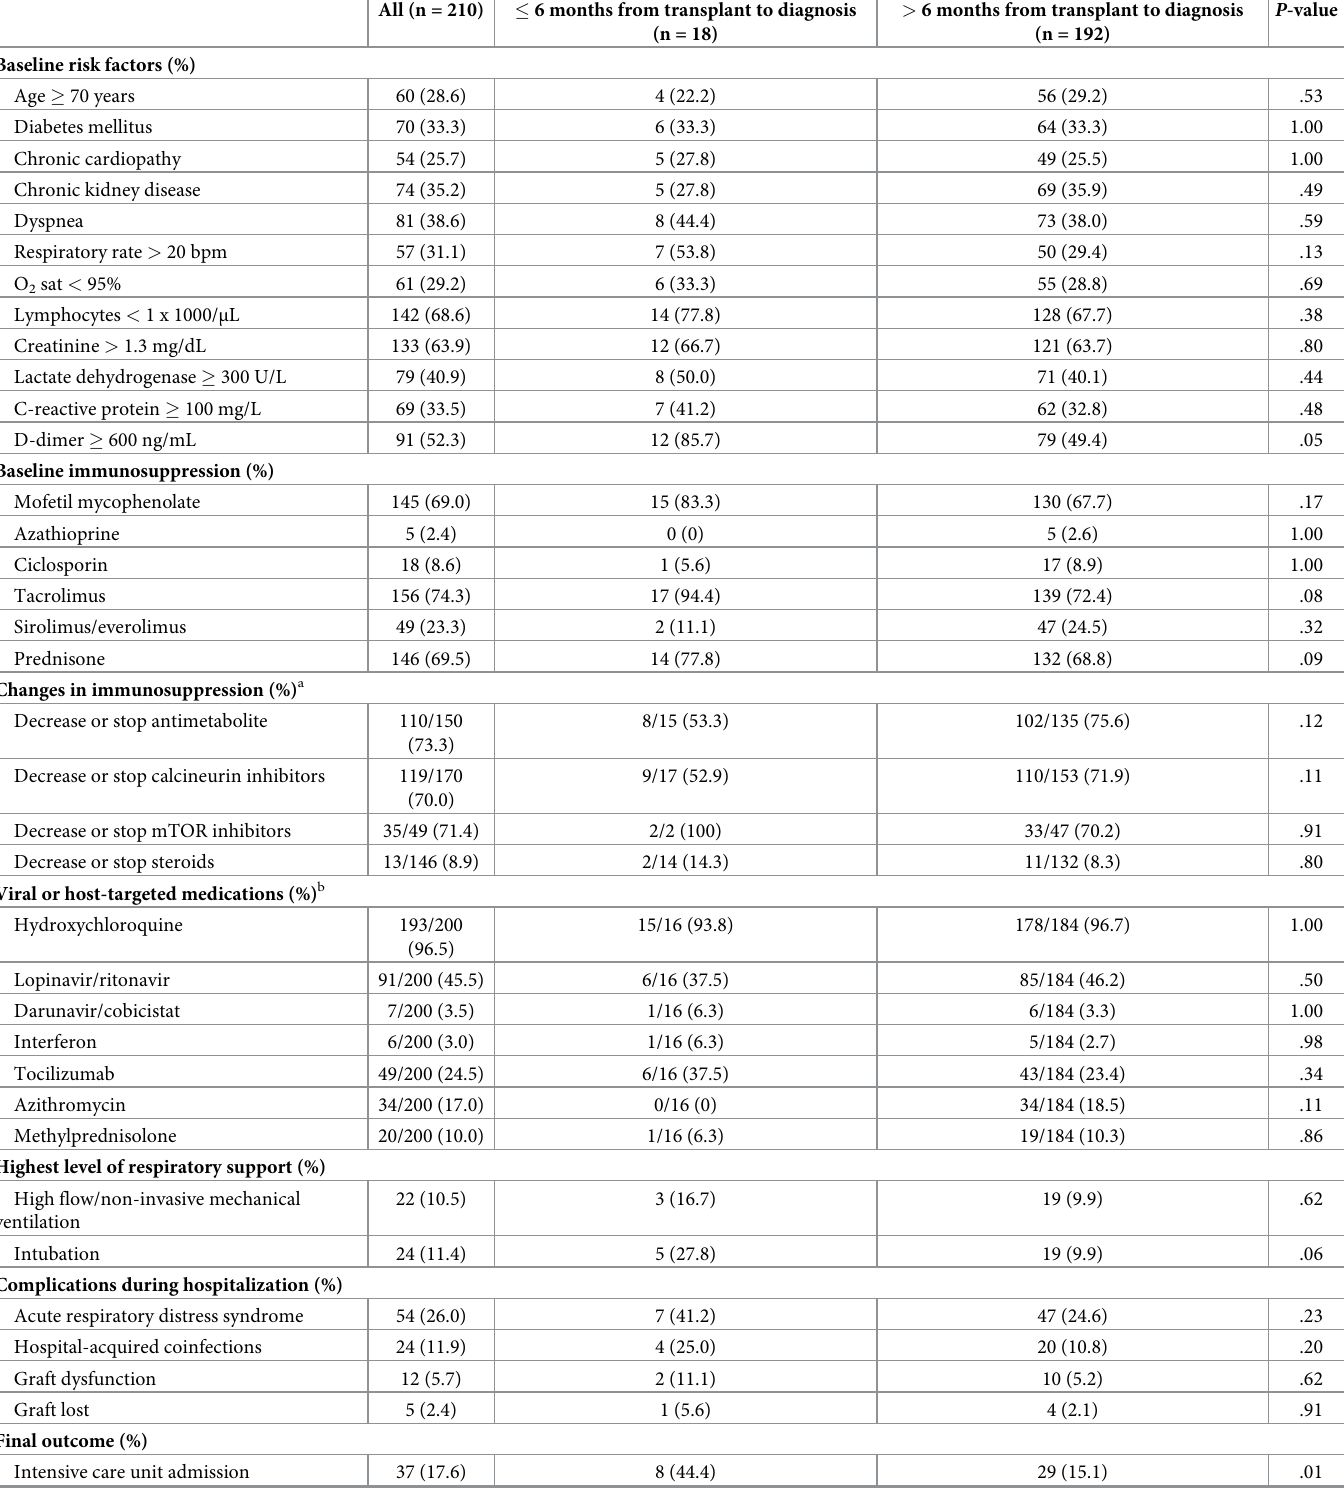
Table 4. Baseline risk factors, management, and outcomes vs . time from transplantation to COVID-19 diagnosis.